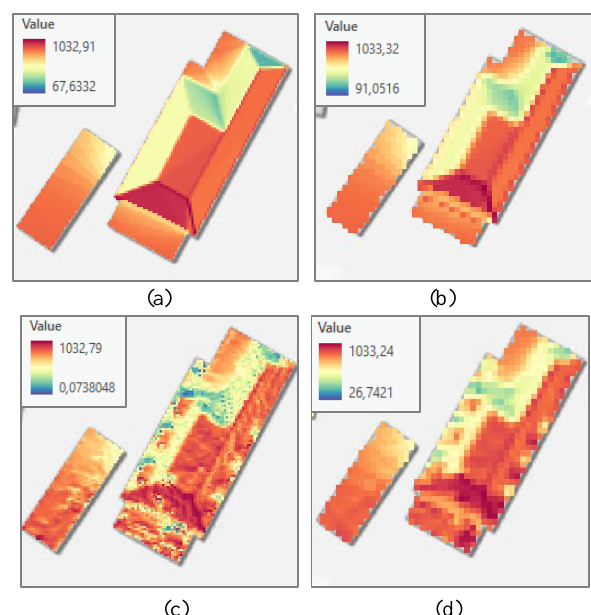
Figure 10. The input data to calculate physical potential calculation with different pixel size left row is 0.2m and right row is 0.5m. Image (a) and (b) is the converted 3D building model and image (c) and (d) is the integrated point cloud converted into raster.